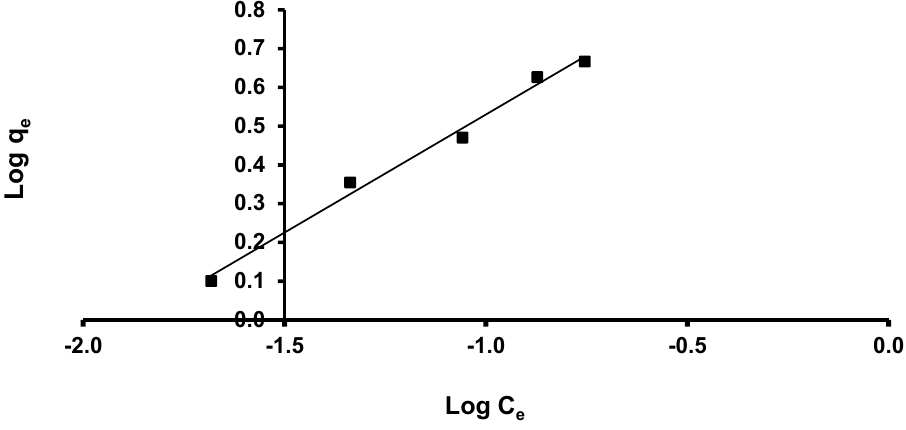
Figure 11. Freundlich isotherm of the IV2R onto the MWCNTs.